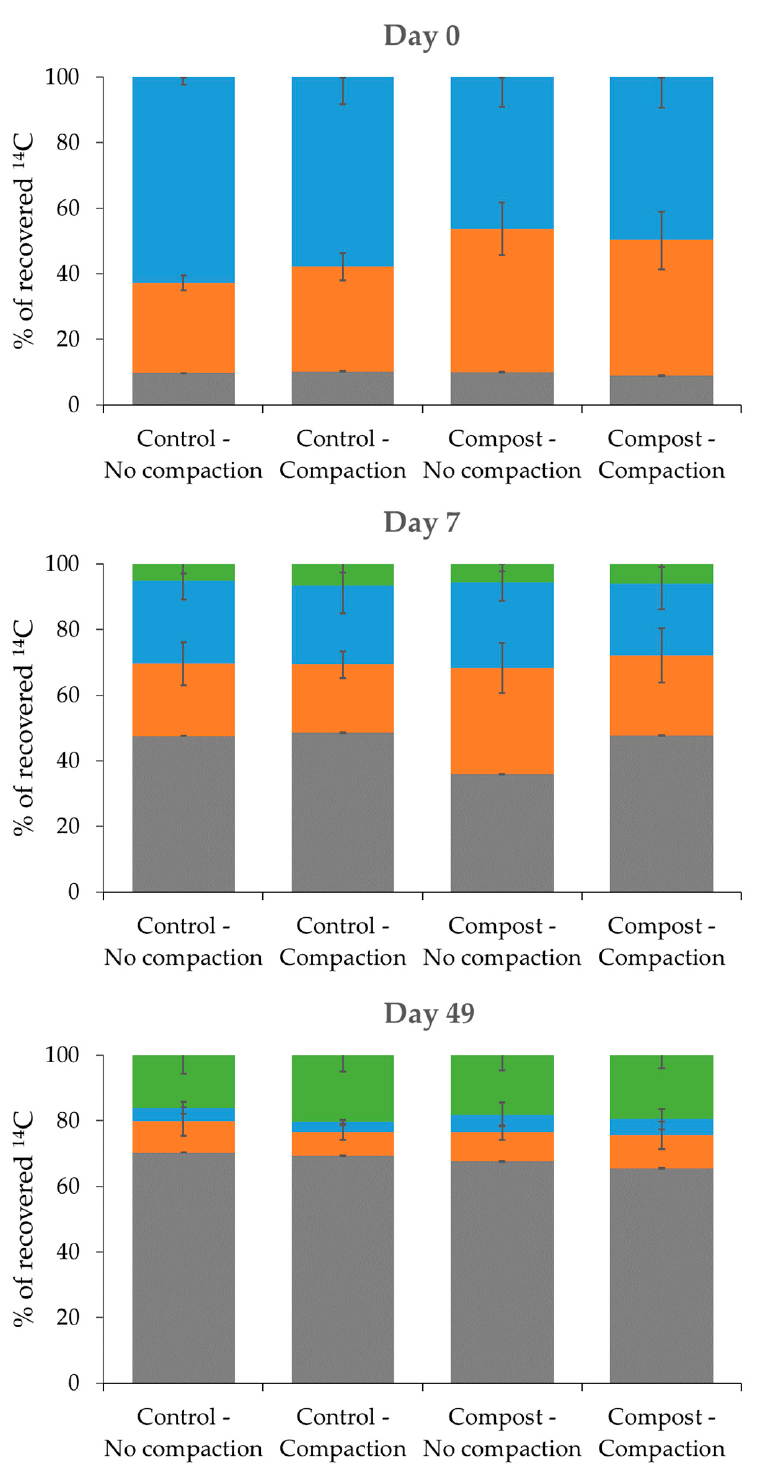
Figure 2. Overall balance of the fate of isoproturon after 0, 7 and 49 days in control (unamended) and compost amended soils, not compacted and compacted: Mineralised; CaCl 2 extractable; CH 3 OH extractable; Non ‐ extractable (bound) residues.